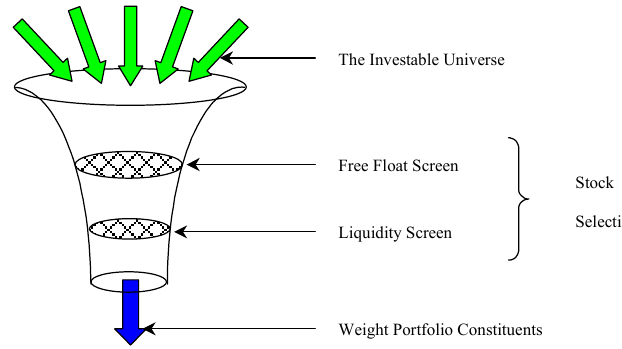
Figure 1: Development of a normal portfolio index Defining of the investable